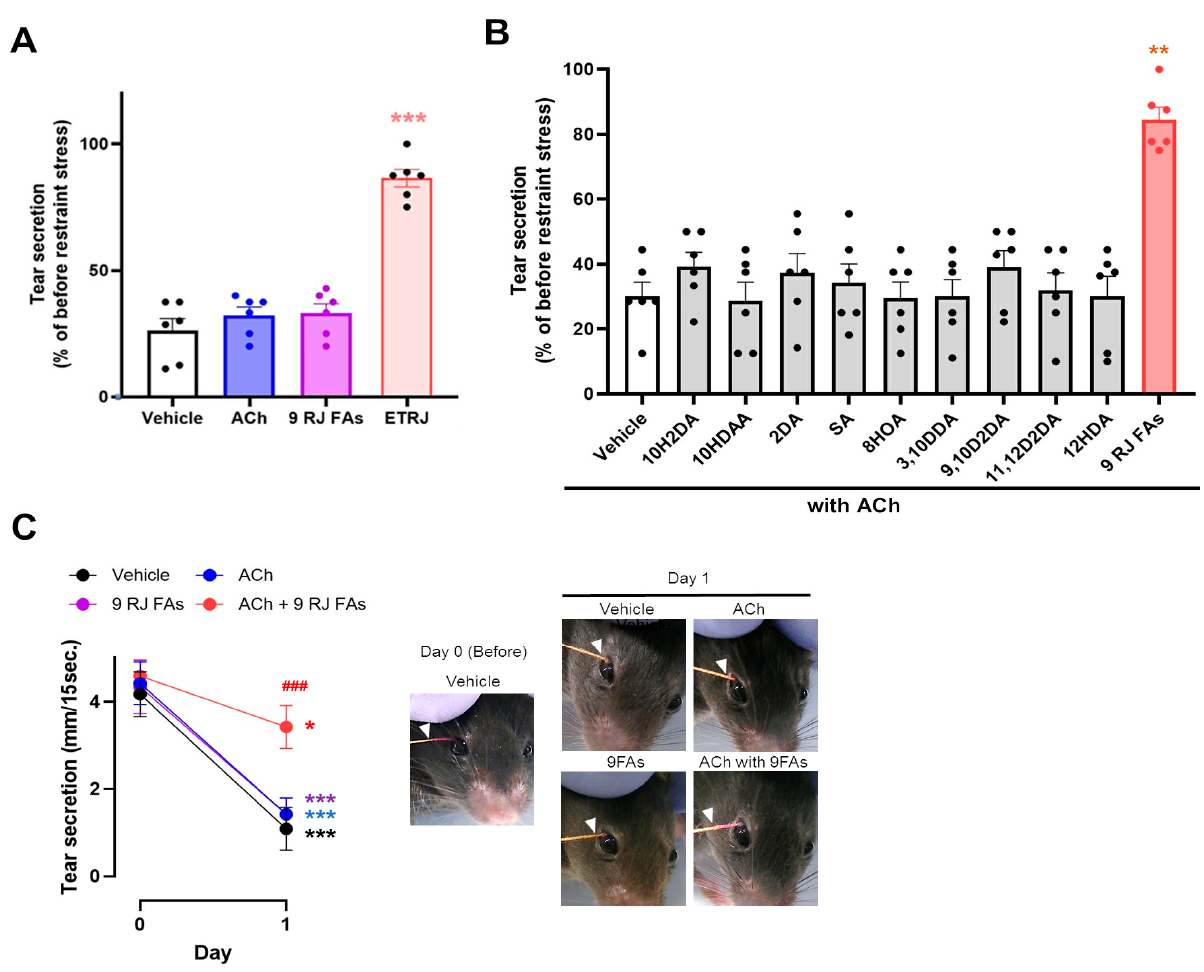
Figure 1. ACh with two or more RJ fatty acids were essential to restore decreased tear secretion. ( A ) Effect of ACh and 9 RJ fatty acids (9 RJ FAs). ( B ) Effect of a combination of ACh with RJ fatty acids on tear secretion. ( C ) Change in measured value in tear secretion ( left ) and representative photographs measured with a cotton thread ( right ). The value was calculated as a percentage of tear secretion at 1 day after restraint stress exposure compared to before restraint stress. ( A , B ) All data represent the mean ± SEM, n = 6 mice eyes. * p < 0.05, ** p < 0.01, *** p < 0.001 versus vehicle ( A , B ) or day 0, ### p < 0.001 versus vehicle ( C ).